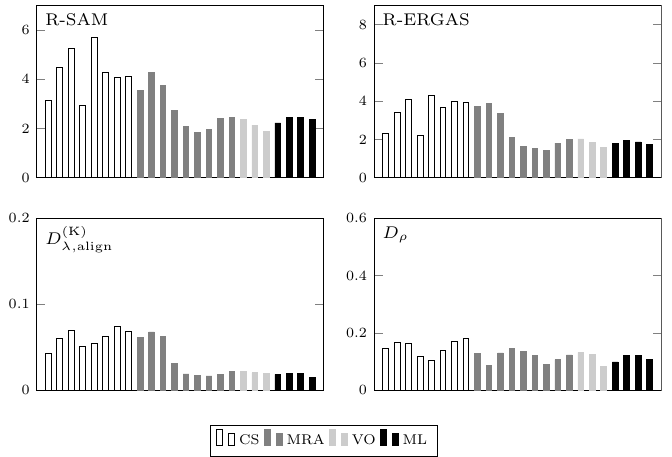
Figure 9. Full-resolution assessment on the WV3 dataset. R- Q 2 n is replaced by its complement D ( K ) for the sake of readability (0 is the ideal value for all). For details on methods and related λ ,align categories (CS, MRA, VO, ML), refer to Table 2.